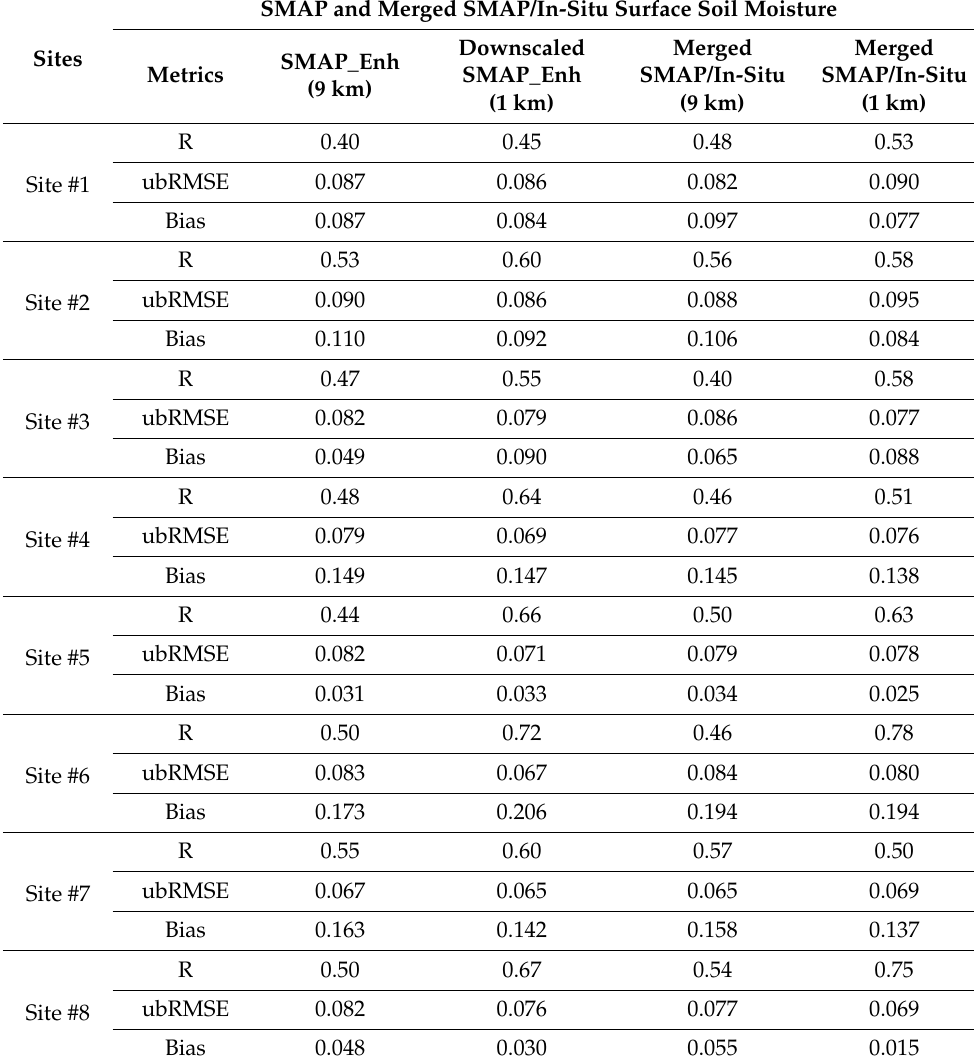
Table 1. The performance metrics for SMAP-enhanced and merged SMAP/in-situ soil moisture.